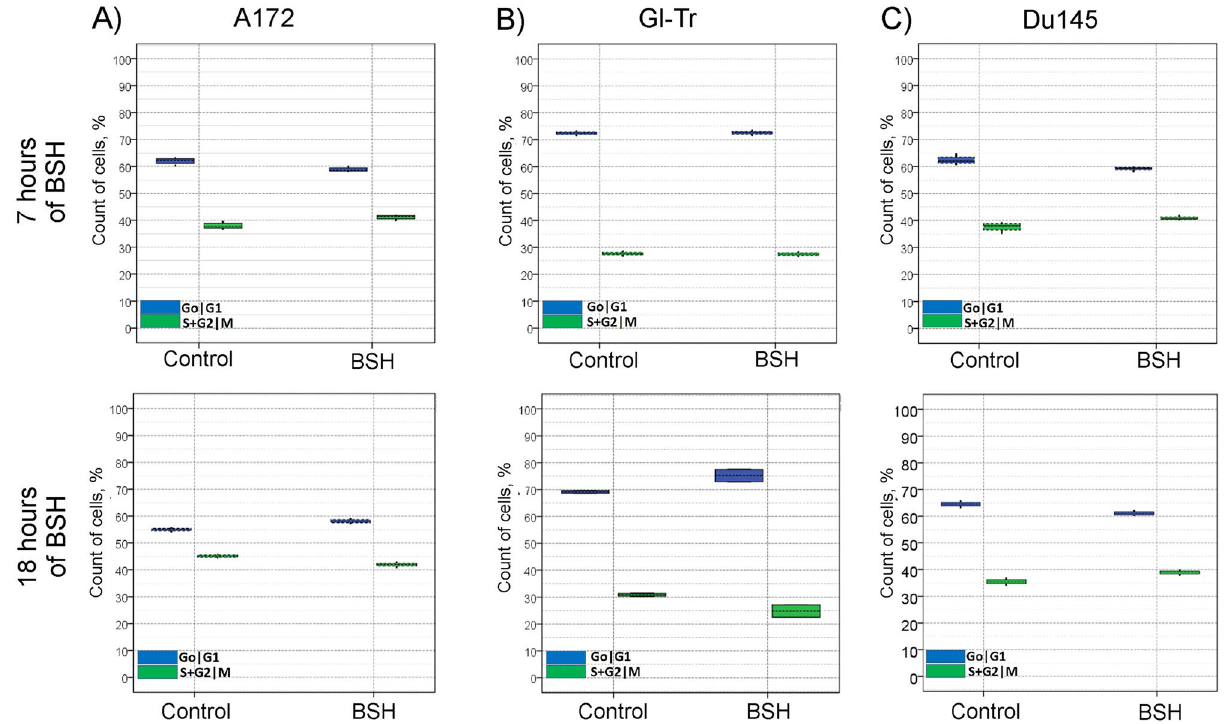
Figure 2. Distribution of A172 ( A ), Gl-Tr ( B ) glioma cells, and Du145 prostate cancer cells ( C ) over the phases of the cell cycle after incubation with sodium borocaptate (BSH) at a boron-11 concentration of 80 ppm for 7 h (up panels) or 18 h (bottom